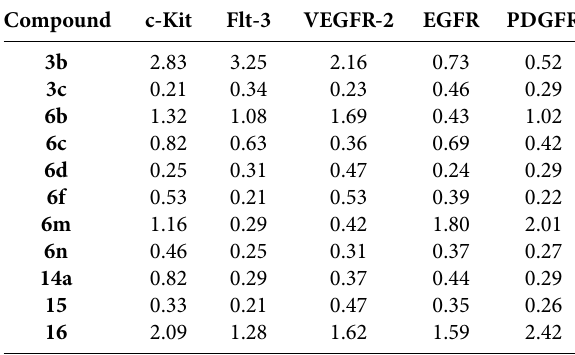
Table 2. Inhibitions of tyrosine kinases [Enzyme IC 50 (nM)] by compounds 3b , 3c , 6b , 6c , 6d , 6f , 6m , 6n , 14a , 15 and